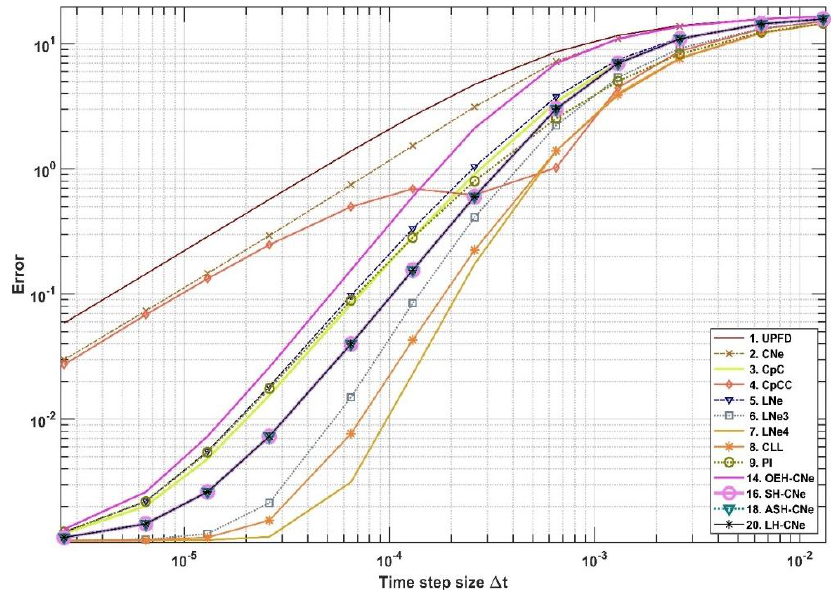
Figure 2. Errors as a function of the time step size for the slowly converging methods.